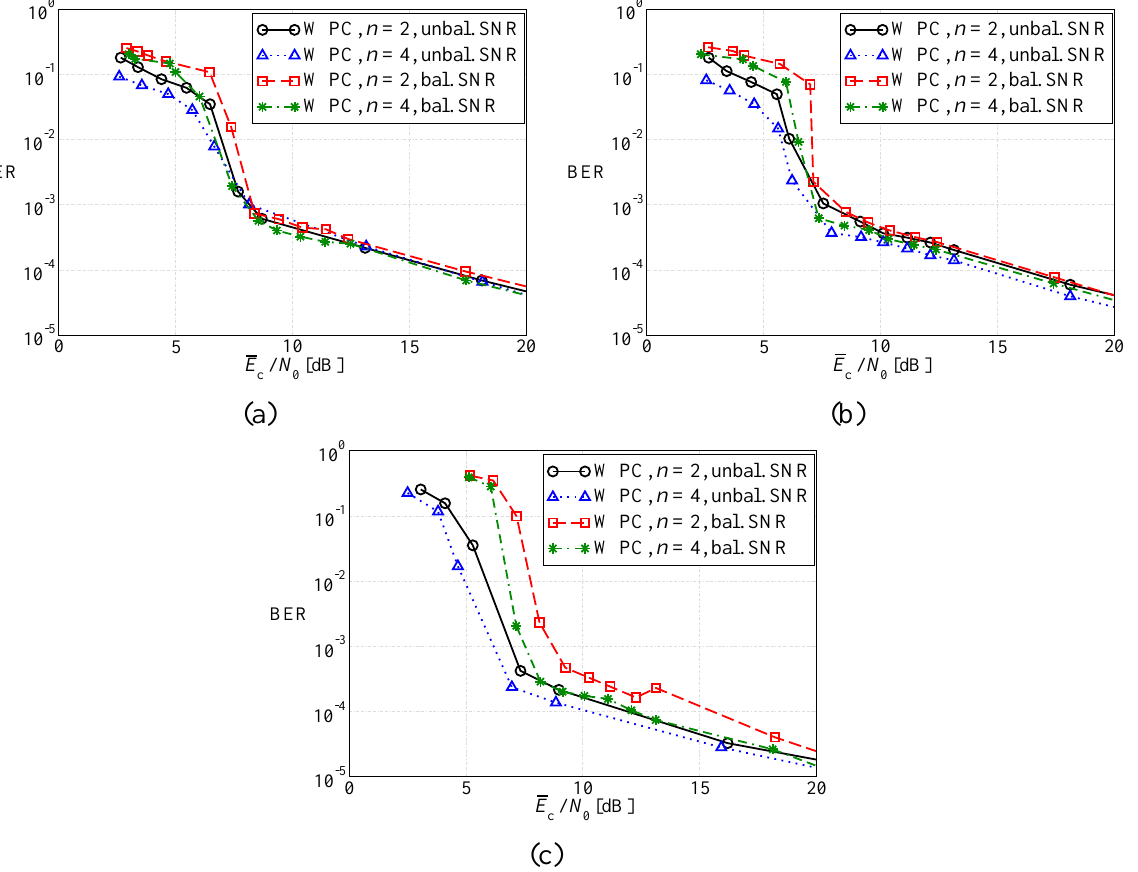
Figure 6. Average BER, as a function of the average SNR at the sources, considering: (a) regular LDPC-coded schemes, (b) DD LDPC-coded schemes, and (c) SCCCed schemes. Both balanced SNR and unbalanced SNR power control strategies are